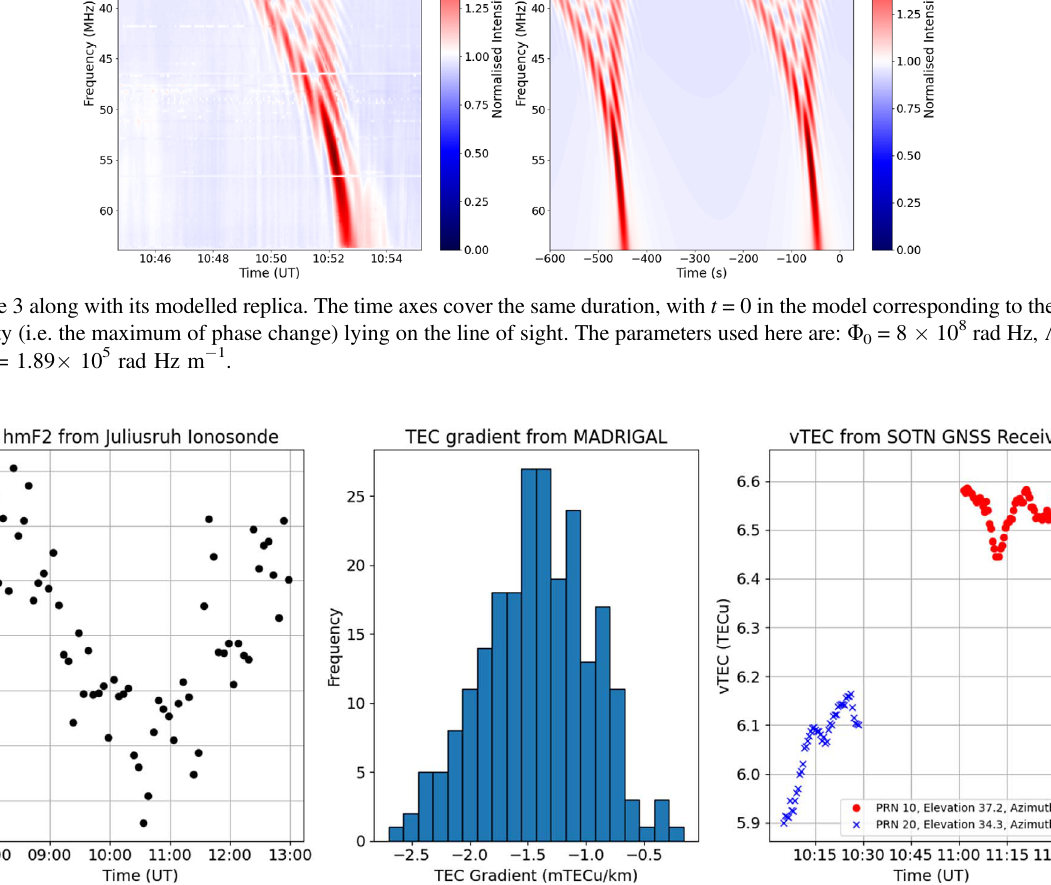
Fig. 5. The additional data used to constrain the model parameters. The leftmost panel shows the altitude of peak ionospheric electron density (hmF2) measured from the Juliusruh ionosonde (54.6 (cid:3) N, 13.6 (cid:3) E). The middle panel shows the distribution of north-south vTEC (vertical TEC) gradients (positive implies increasing to the north) calculated from MADRIGAL GNSS TEC based on the difference over 4 (cid:3) of latitude centred on points between 58 (cid:3) – 61 (cid:3) N, 5 (cid:3) – 7 (cid:3) E, and 10:15 – 11:45UT. The third panel shows vTEC measured from the Southampton (SOTN) GNSS receiver (50.9 (cid:3) N, 1.5 (cid:3) W) for all azimuths between 0 (cid:3) and 60 (cid:3) clockwise from the